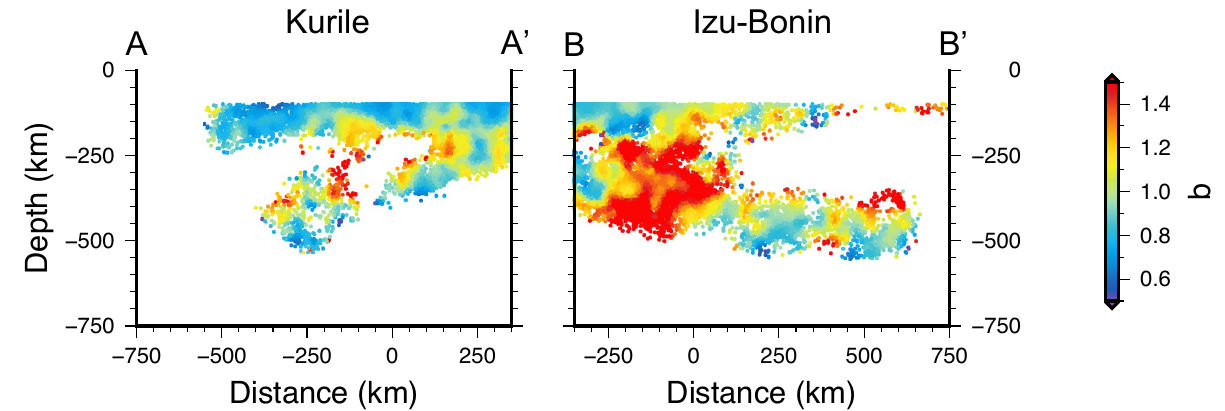
Figure 3. Distribution of the Gutenberg–Richter b -value. Estimates for earthquakes in the Kurile and Izu– Bonin subduction zones projected on the vertical sections corresponding to the black traces in Fig. 1. The b -value is inversely correlated with the deviatoric stress, thus lower (higher) values indicate higher (lower)